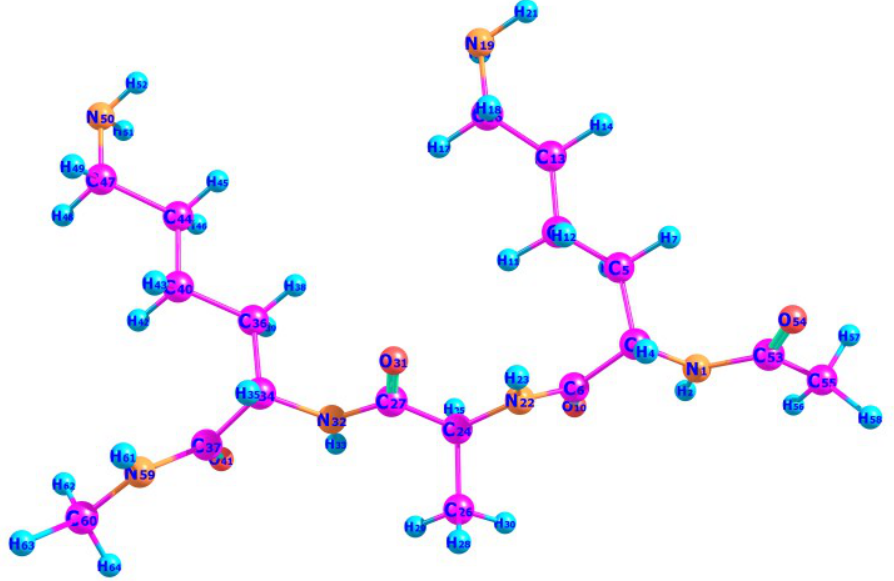
Figure 1. Geometrical conformation for the KAK peptide(Ac-Lys-(Ala) n -Lys-NH2 with n =